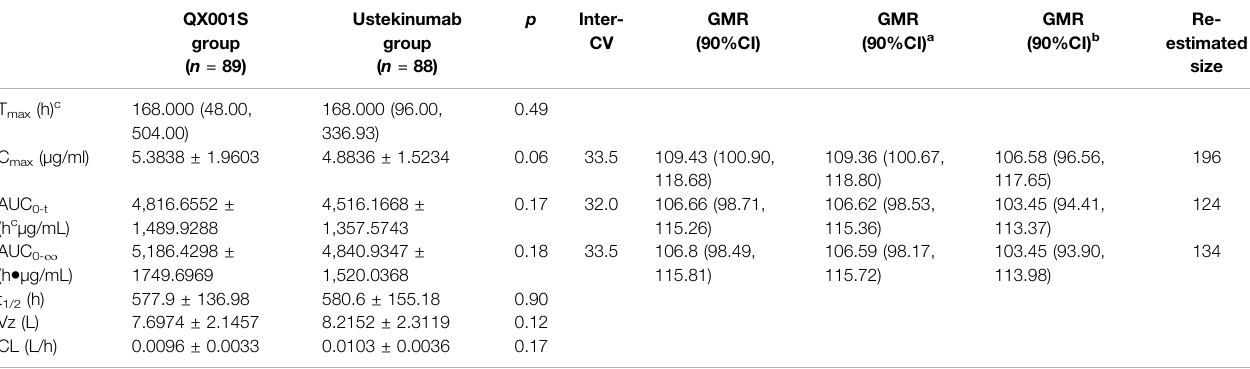
TABLE 2 | Comparison of pharmacokinetic parameters between the QX001S and ustekinumab groups (Mean ± SD or median [min,